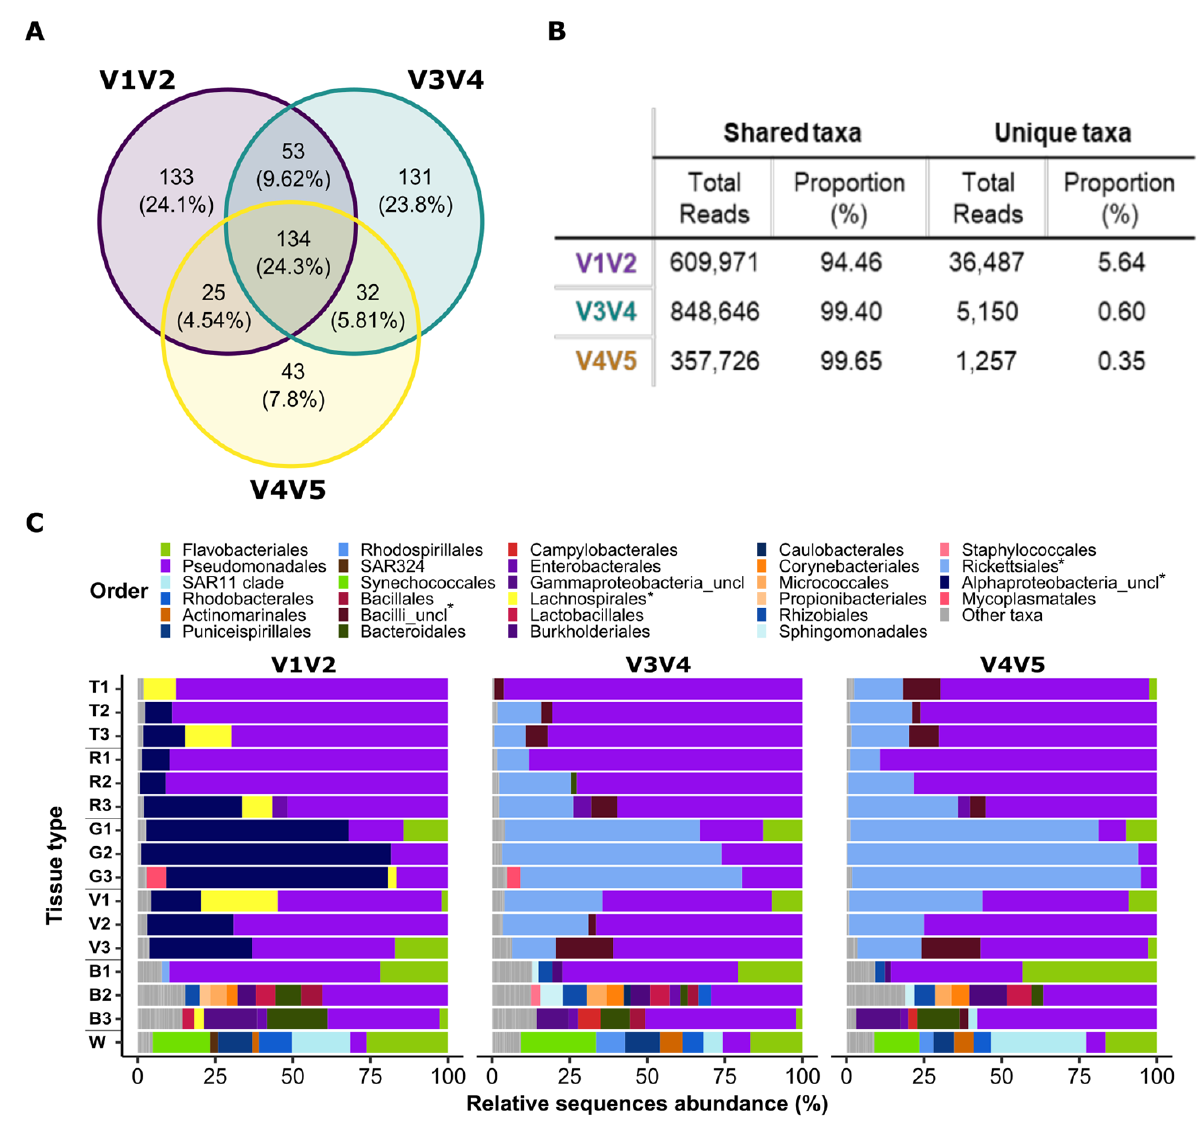
Figure 5. V1V2, V3V4, and V4V5 merged datasets analysis. ( A ) Venn diagram representing all genera from the merged datasets. ( B ) Reads numbers and proportion of shared and unique genera compared with the complete population of each primer. ( C ) Taxonomic compositions (relative sequence abundance) of order level in different tissues of 3 jellyfish (B—bell, G—gonads, T—tentacles, V—gastrovascular canals, and R—rhoplium) and one sample of filtered seawater (W). Taxa with relative sequence abundance of less than 2% were classified as “Other taxa“. * marks the main taxa discussed in this paper.